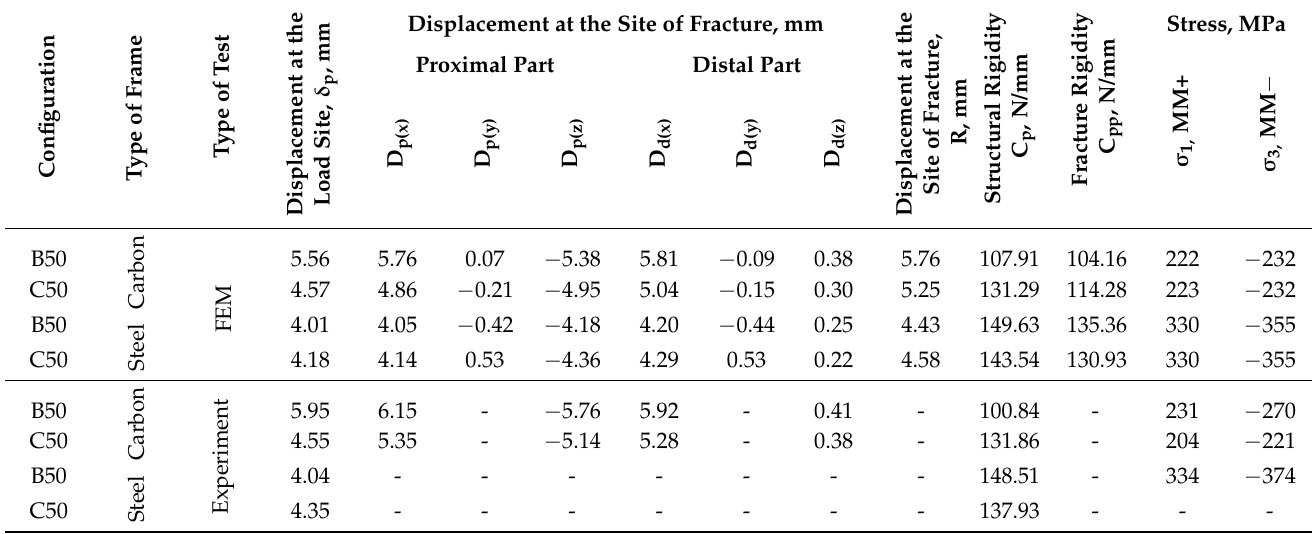
Table 2. Examination results for the Sarafix fixation device.